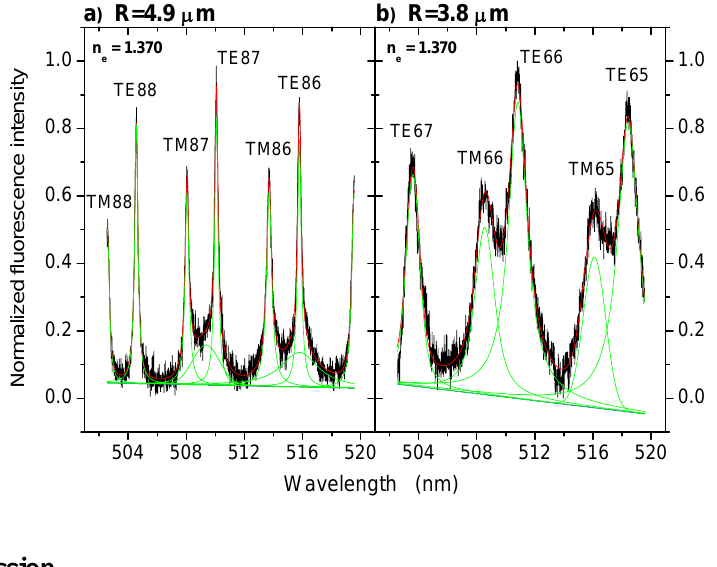
Figure 1. Illustration of the fitting of Voigt profiles and linear background correction to the measured WGM spectra for determination of mode positions and bandwidths. (a) = 1.370. (b) Spectrum of the R = 3.8  m Spectrum of the R = 4.9  m bead at a fluid index, n fl bead at the same fluid index. The mode assignments (polarization followed by mode number,  ) are based on the results of the spectrum